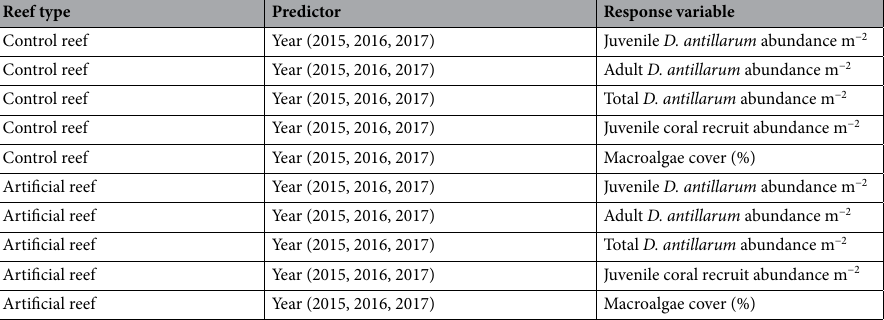
Table 2. Ten Friedman tests were used to assess changes in juvenile, adult, and total D. antillarum population density, juvenile coral recruit abundance, and macroalgae cover over a three-year period. Changes in the value of each variable were assessed independently, and separate analyses were conducted for the control and artificial